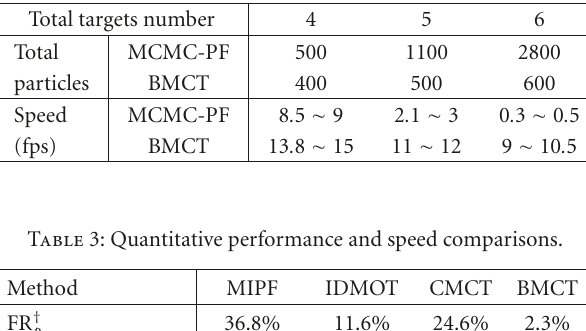
Table 2: Complexity analysis in terms of the number of targets.